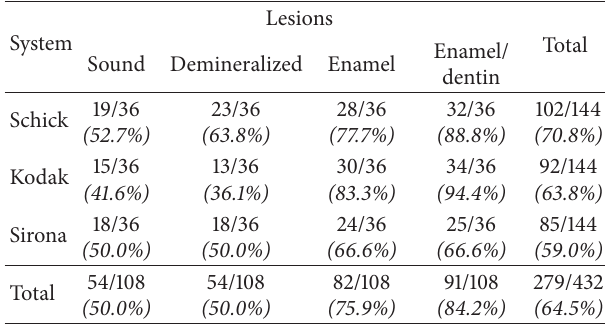
Table 2: Proportion of correct diagnoses according to radiographic system and type of lesion ( 𝑛 =